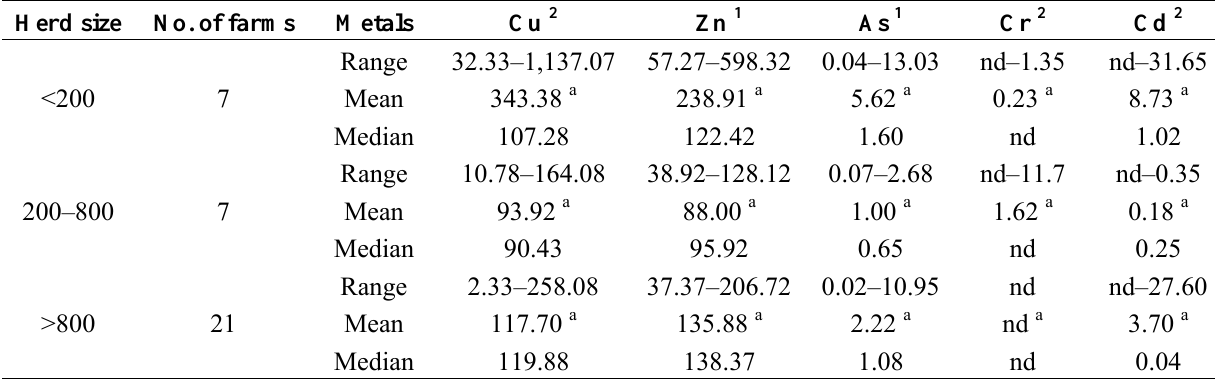
nd: non-detectable. Different letters (superscripts) in the same column indicate the signi fi cant